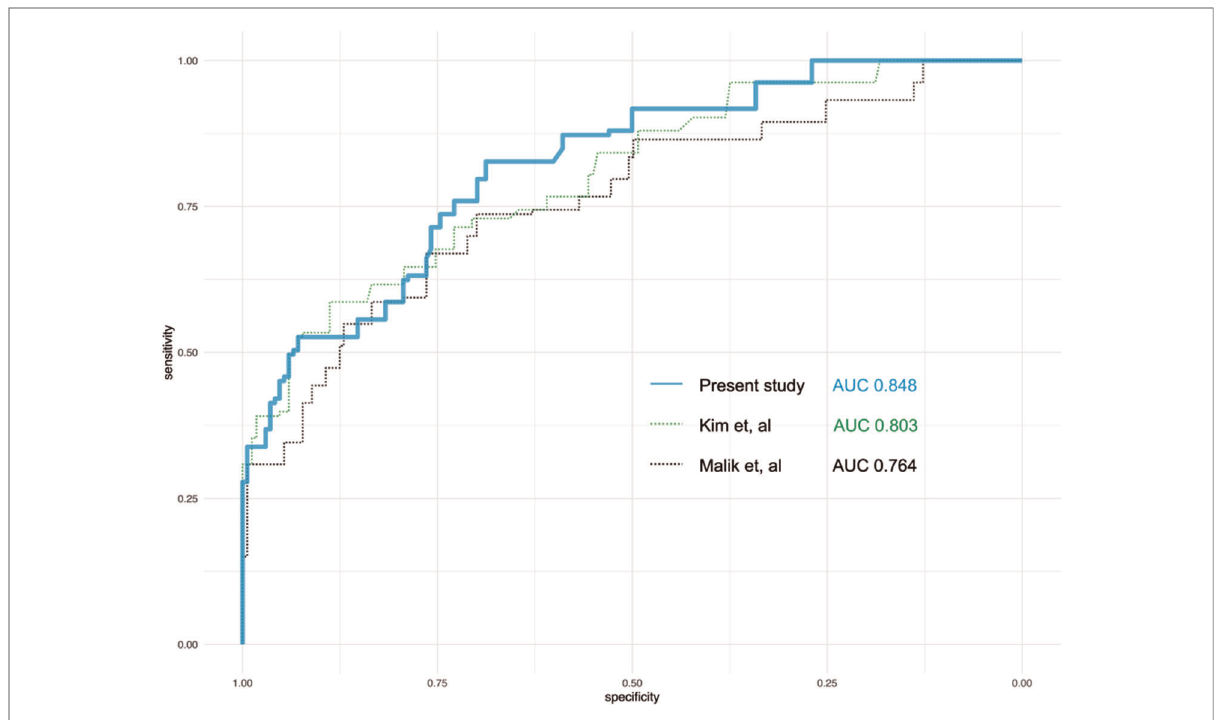
FIGURE 2 Comparison of the performance of the predicting models from the present study and two previous studies. AUC, area under the